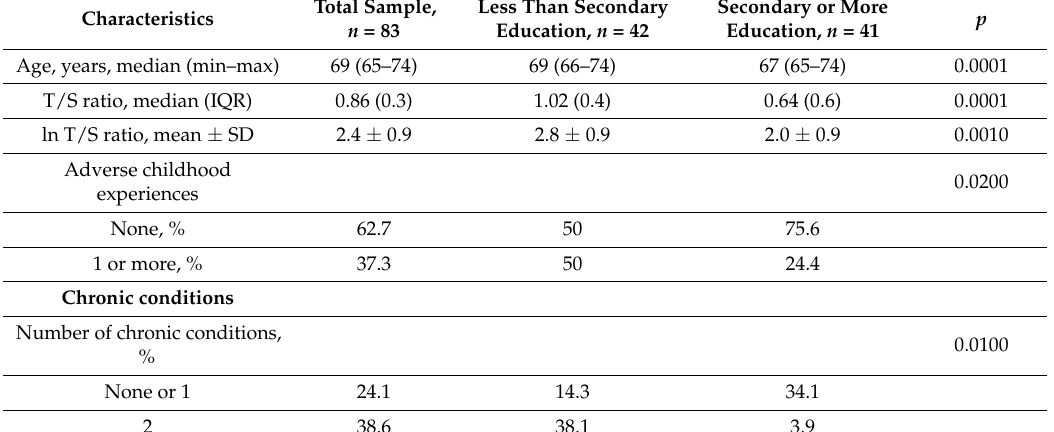
Table 1. Study population